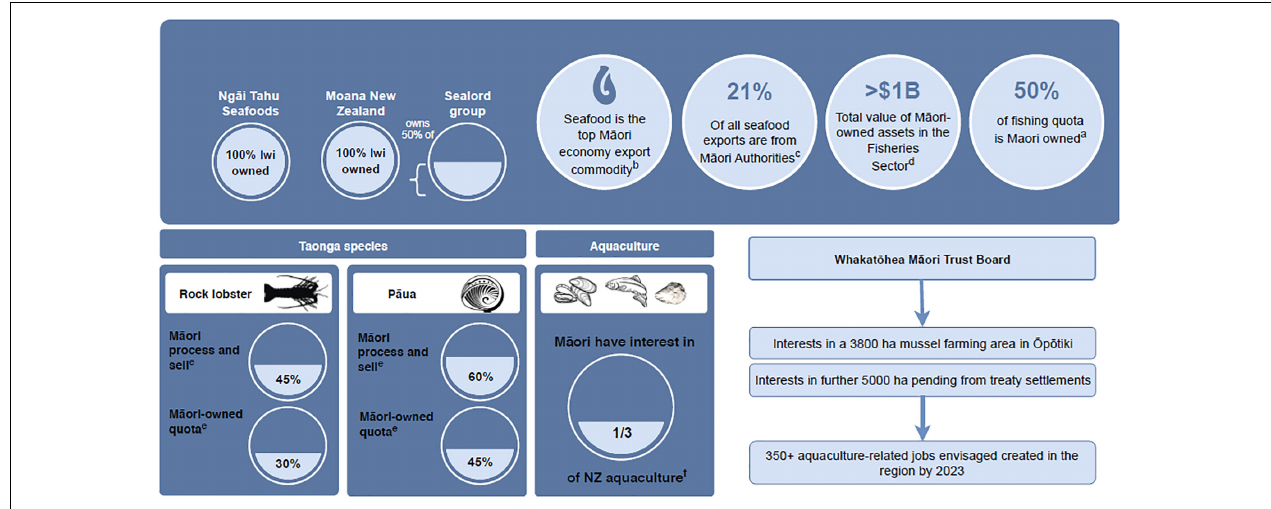
FIGURE 1 | The economic benefit of fisheries and aquaculture to M¯aori, including Whakat¯ohea M¯aori Trust Board. a Inns (2013). b NZ Government Business Growth Agenda. c Joseph (2017). d Nana et al. (2011). e McClurg (personal communication). f NZ Aquaculture (personal